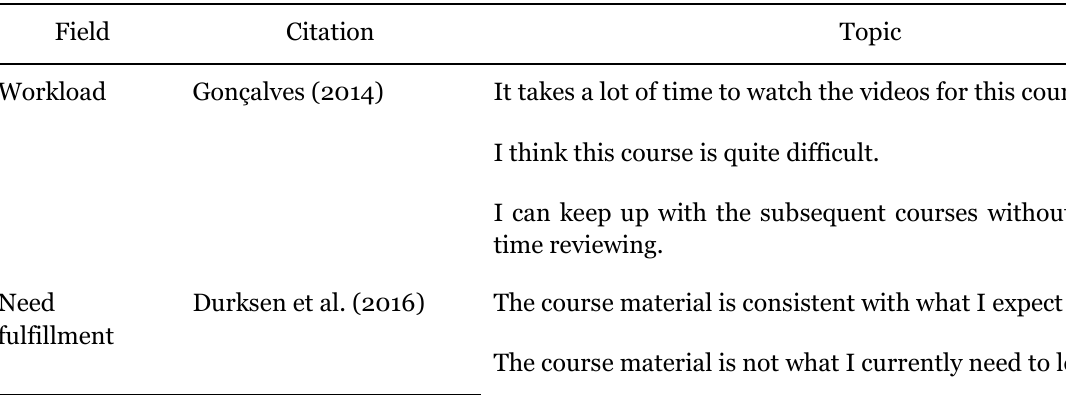
Questionnaire Design and